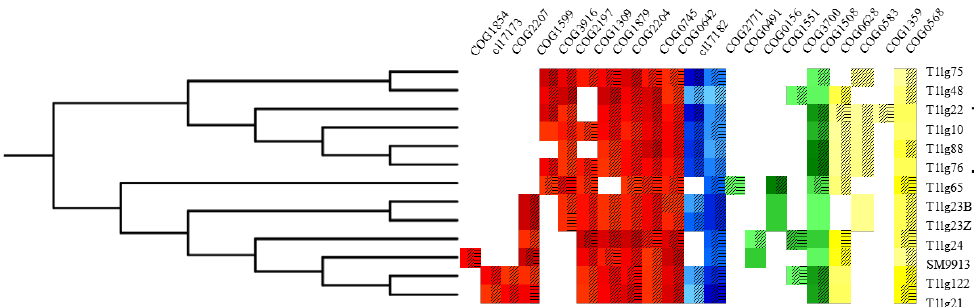
Figure 1. Heatmap schema of quorum sensing regulator dissemination in selected Pseudoalteromonas genomes. The left panel of the heatmap is the evolutionary tree. The middle of the heatmap denotes the distribution of QS regulatory protein families in thirteen Pseudoalteromonas isolates. The top of the heatmap corresponds to the protein family IDs. Red: positive regulation; blue: both positive and negative regulation; green: negative regulation; yellow: unknown regulation direction. The color intensity represents the relative amount of the nucleotide base numbers of the genes containing cognate protein family (heavy: more similarity; moderate: intermediate similarity; light: less similarity). A range of BLAST hits were found to be classified into the same protein family. Notably, identified conserved and diverse genes are labeled with matching signatures; white: no hits; oblique stripes: relatively conservative; horizontal stripes: absolutely specific; others: absolutely conservative.